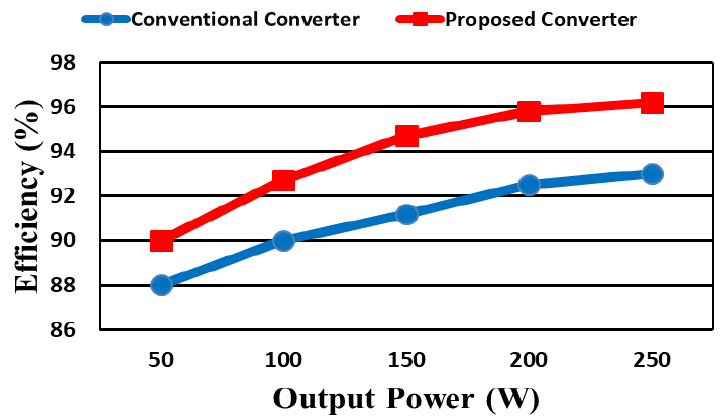
Figure 21. Efficiency curve of the proposed converter under different load conditions.